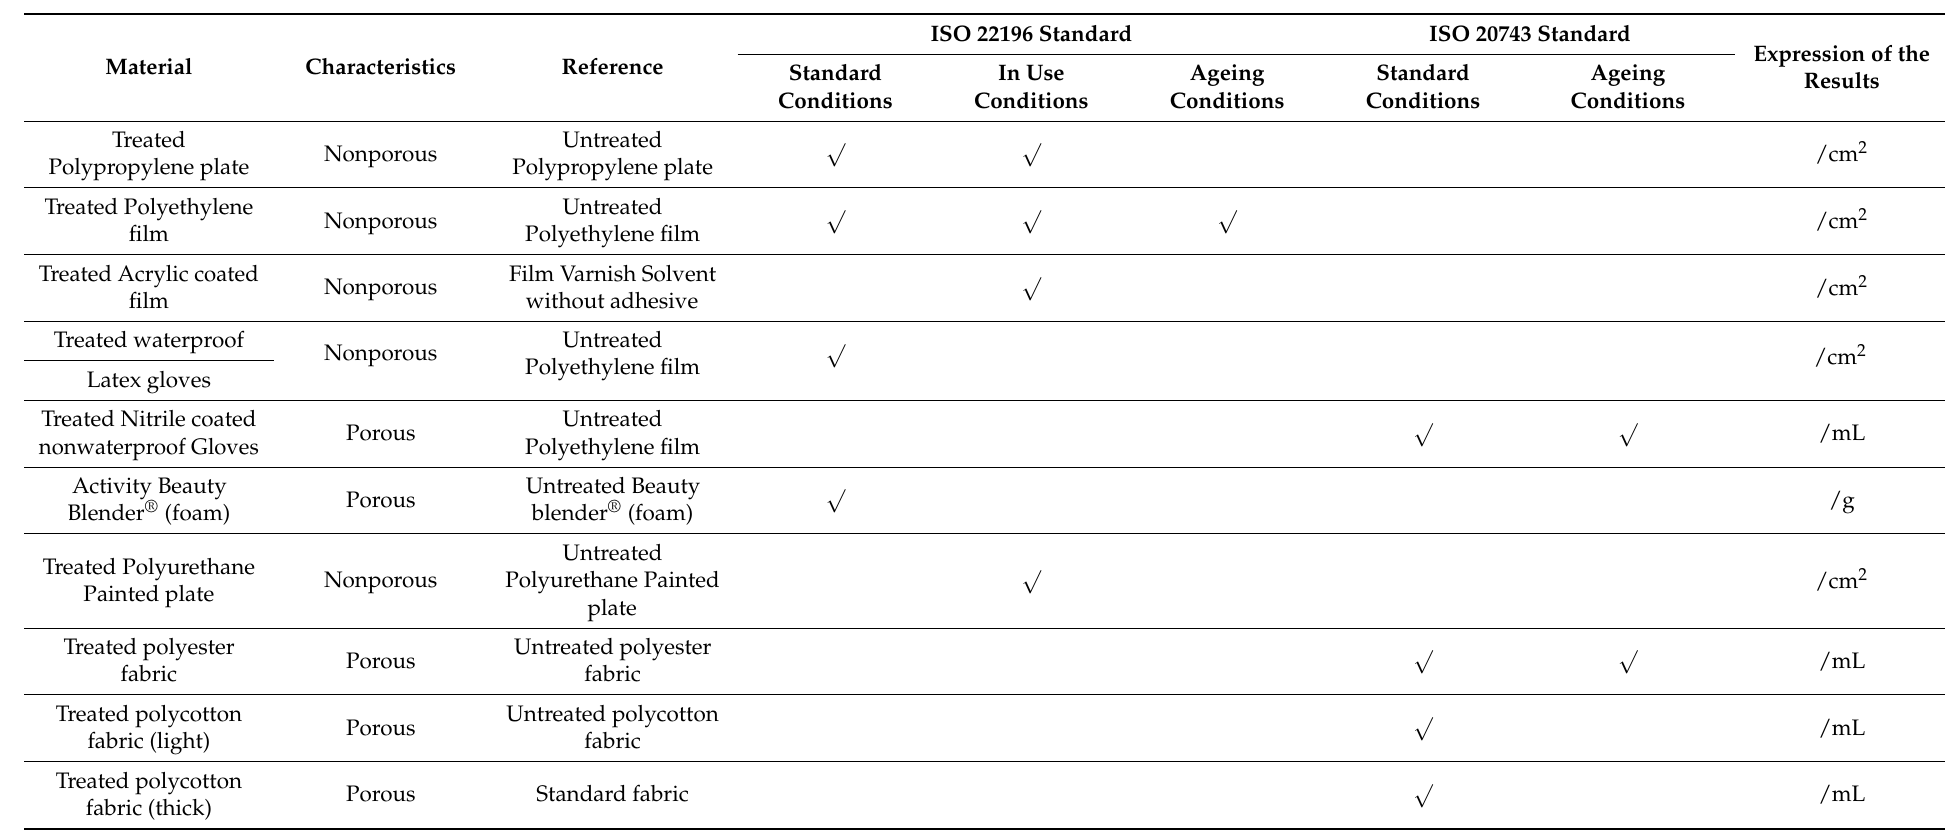
Table 1. Tested materials and reference